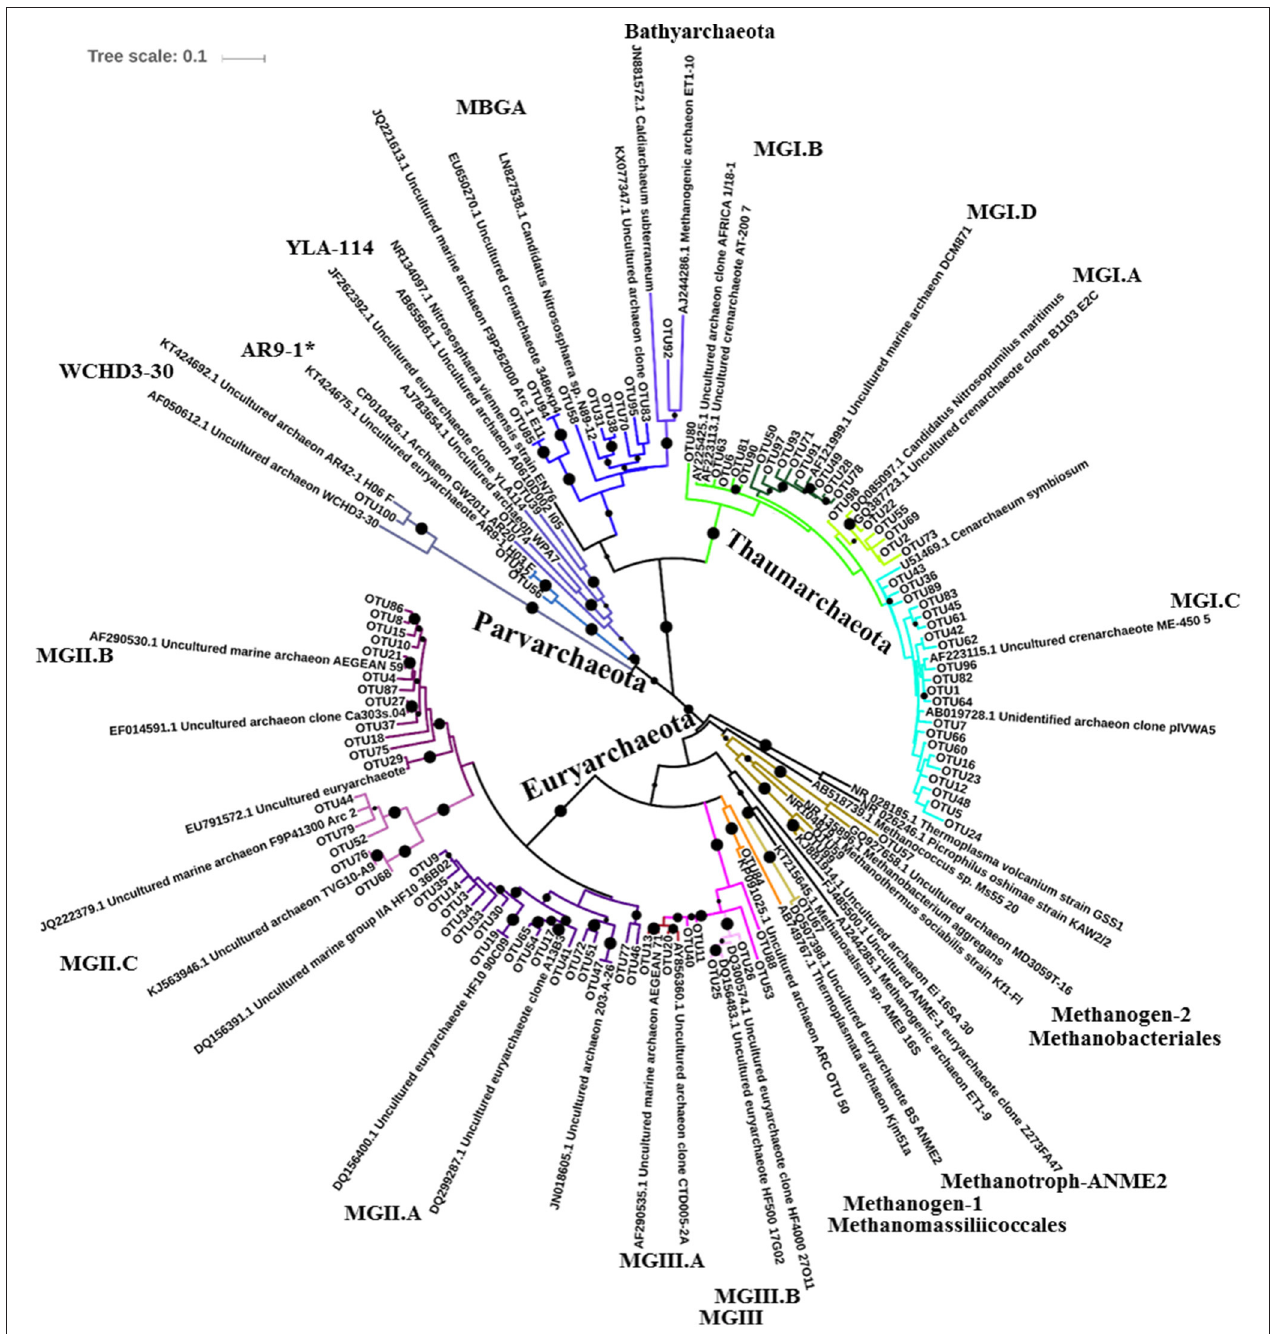
FIGURE 4 | Maximum likelihood phylogenetic tree of the archaeal 16S rRNA gene sequences (representative sequences of the top 100 abundant OTUs). Dots over the nodes represent branches with bootstrap values > 50%. The different archaeal groups are indicated by the different colors.